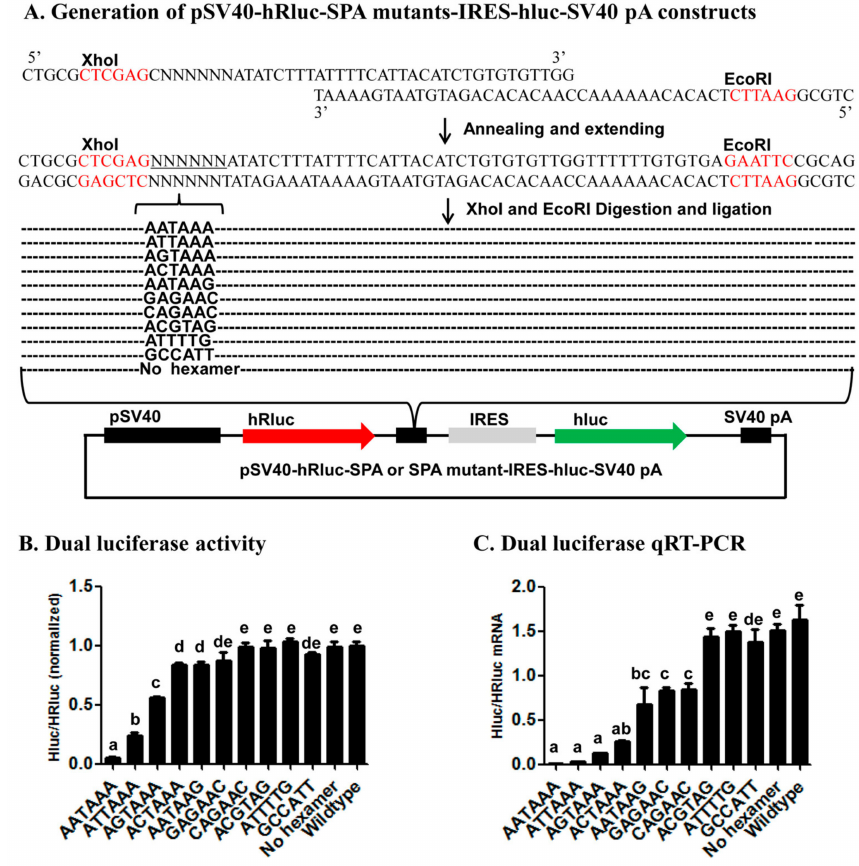
Figure 5. Effects of inserting SPA mutants with different hexamer variants on the relative expression of the two luciferase reporter genes. ( A ) Generation of pSV40-hRluc-SPA mutants-IRES-hluc-SV40 pA constructs; ( B ) Dual luciferase activity; ( C ) Dual luciferase qRT-PCR. The data and error bars in ( B , C ) represent the means and standard errors of at least three independent transfections for each wildtype vector or SPA mutant construct. Values sharing the same letter are not significantly different at p <